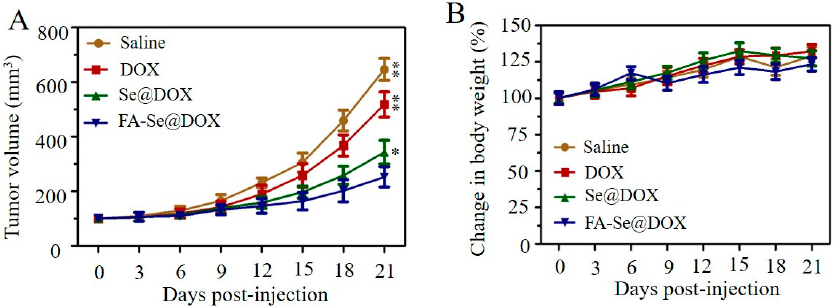
Figure 8. ( A ) Tumor growth curve of the xenograft nude mice bearing HeLa cells after the intravenous administration of saline and various formulations of DOX. * p < 0.05, ** p < 0.01 vs. saline group. ( B ) The body weight change of mice during the treatments.